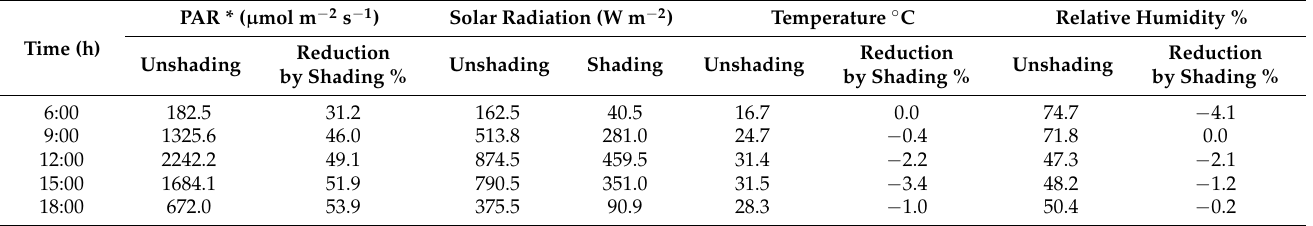
Table 2. Influence of shading on the growing environmentparameters (average day in July).